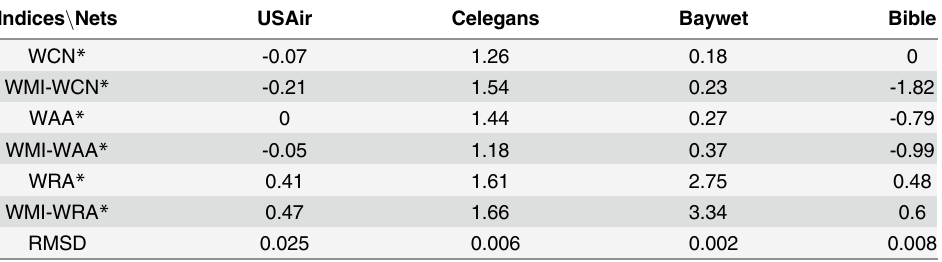
Table 5. Estimated optimal values of parameter α subject to the highest Precision values validated by the validation sets in four networks, respectively. The original network is divided into three parts: training set, validation set and probe set. The proportions are 80%, 10% and 10%, respectively. RMSD is the root mean-square deviation of the Precision values with estimated α values and optimal α values in Table 2, respectively, in each network. Indices n Nets